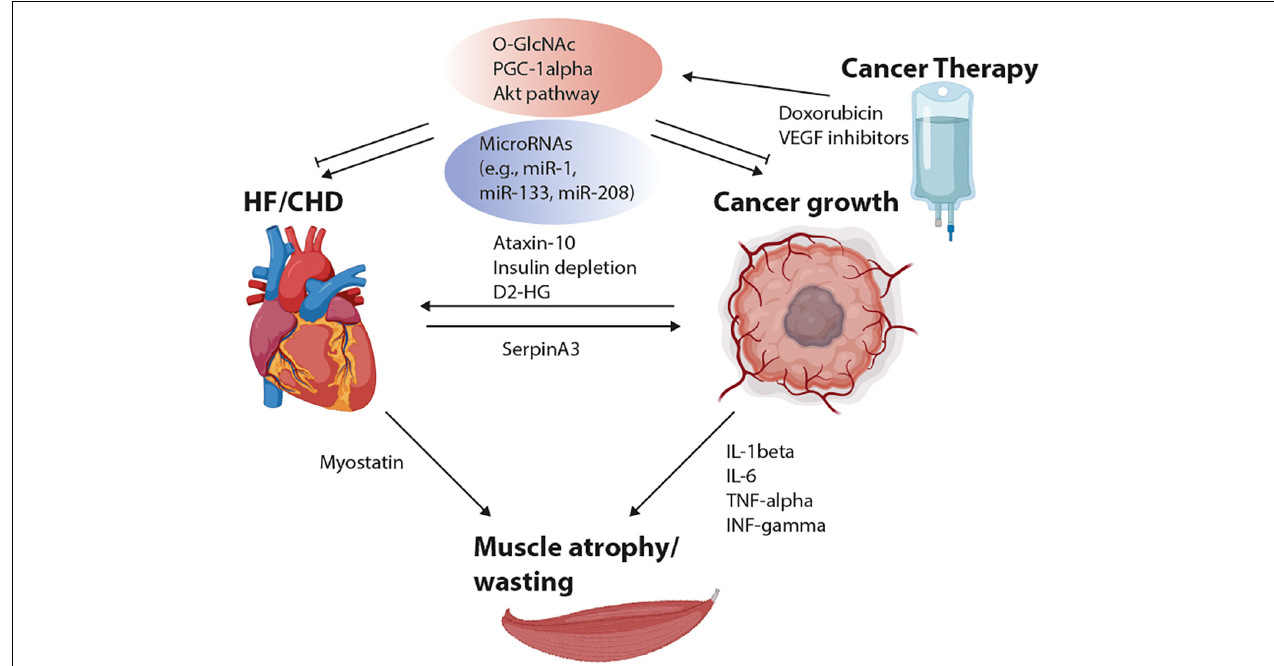
FIGURE 1 | Scheme of interacting factors between heart failure (HF), coronary heart disease (CHD), cancer growth, and muscle atrophy. Cytokine release from the tumor (Ataxin-10, D2-HG, IL-1/6, TNF- α , and INF- γ ) may influence cardiac function and muscle wasting. Released factors from the heart, such as Myostatin and SerpinA3 are able to regulate muscular and cancer growth. Alterations in microRNAs (miRs) and metabolic pathways, including the hexosamine biosynthesis pathways (HBPs), PGC-1 α and Akt activation are regulating cardiac remodeling as well as tumor growth. The adaptations in metabolic signaling pathways may be influenced by chemotherapies, e.g., by VEGF inhibitors and doxorubicin. D2-HG, D-2-hydroxyglurate; INF- γ , Interferon-gamma; IL, Interleukin; PGC-1 α , Peroxisome proliferator-activated receptor-gamma coactivator; Akt, Protein kinase B; TNF- α , Tumor necrosis factor alpha; VEGF, Vascular endothelial growth factor. Created with